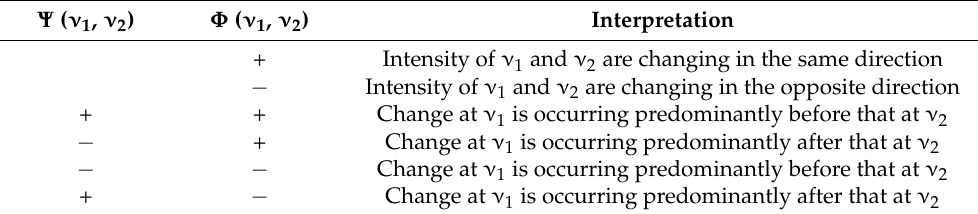
Table 5. Noda’s rule and method for determining crossing peaks in